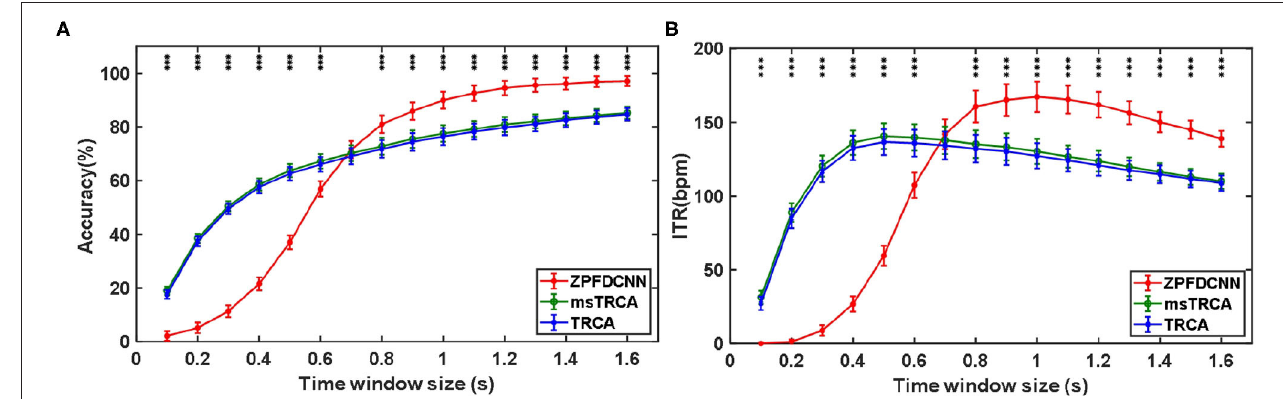
FIGURE 5 | (A) Average classification accuracy of the BETA:SSVEP dataset. (B) The average ITR of the BETA:SSVEP dataset with a visual shift time of 0.55 s. The error bars indicate standard errors. Note that * denotes p < 0.05, ** denotes p < 0.01, *** denotes p < 0.001 according to one-way repeated measure ANOVAs.